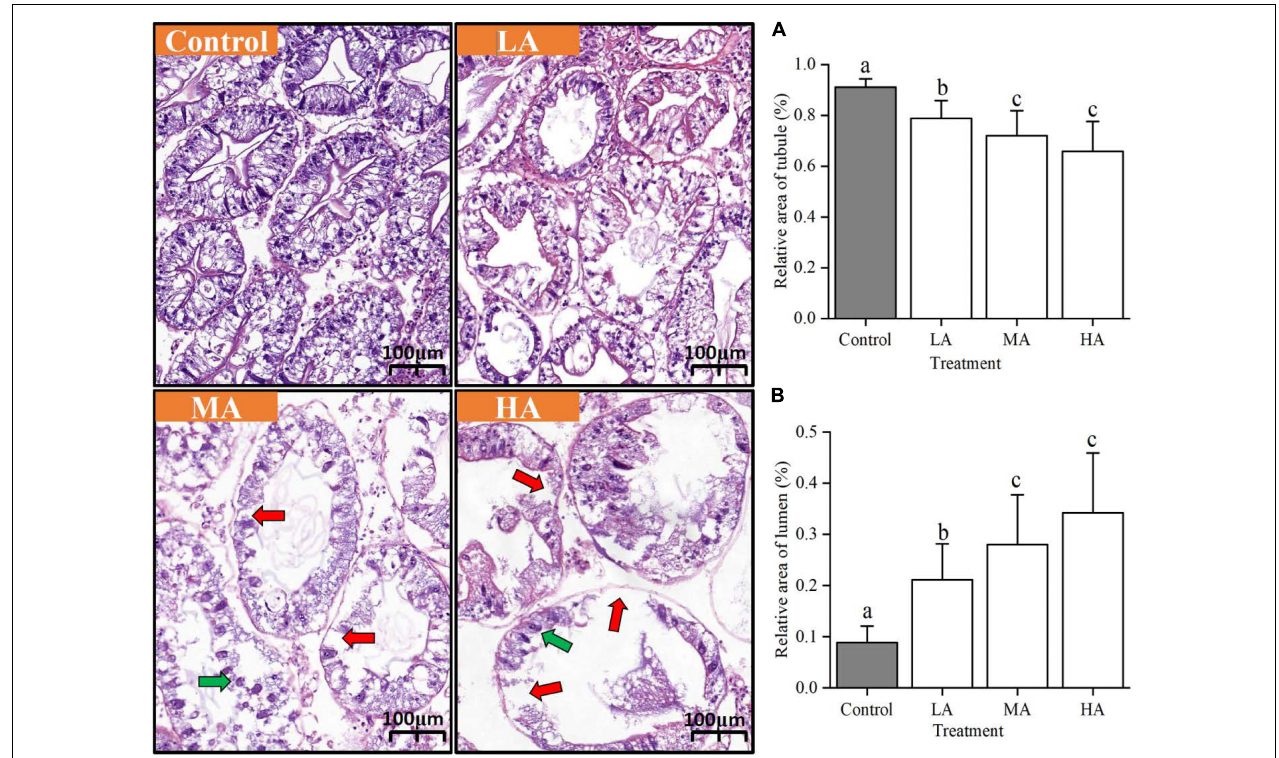
FIGURE 1 | Histological changes in the hepatopancreas of ammonia-stressed P. trituberculatus . (A) Relative area of tubule, (B) relative area of lumen. Red arrow: damaged cellular structure. Green arrow: nuclear condense. Data are represented as mean ± S.D., with P < 0.05 considered significant. Data are represented as mean ± S.D., n = 13-15, with P < 0.05 considered